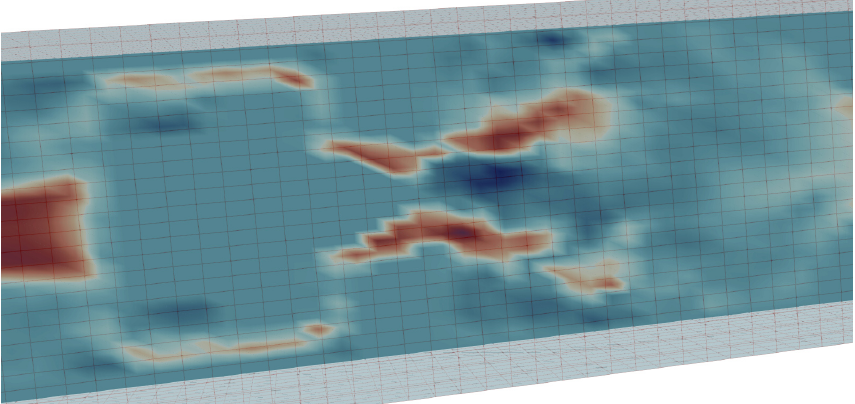
Figure 21. A 2D plane of the finite element projection of the instantaneous velocity shown in Figure 20, on a Cartesian mesh of size 60 × 28 ×